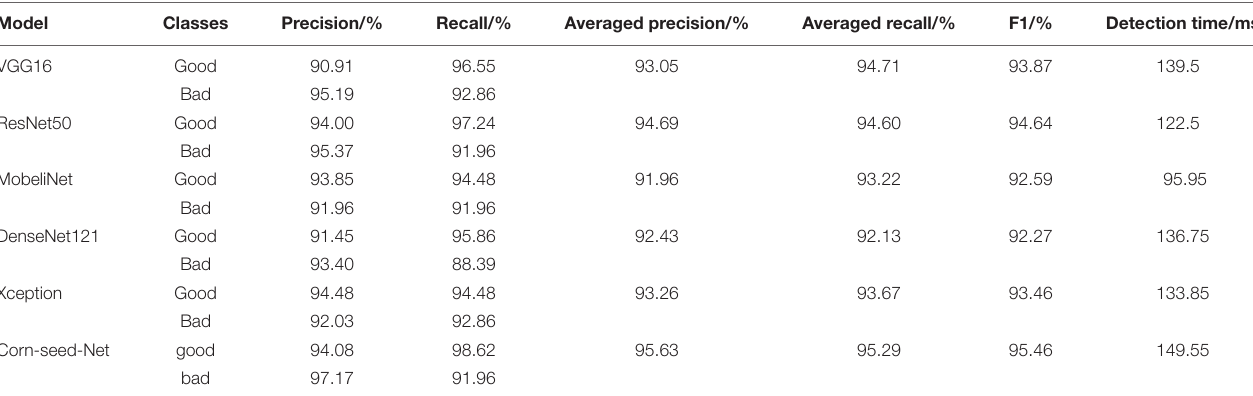
TABLE 3 | Comparison of model performance combined with watershed algorithm.